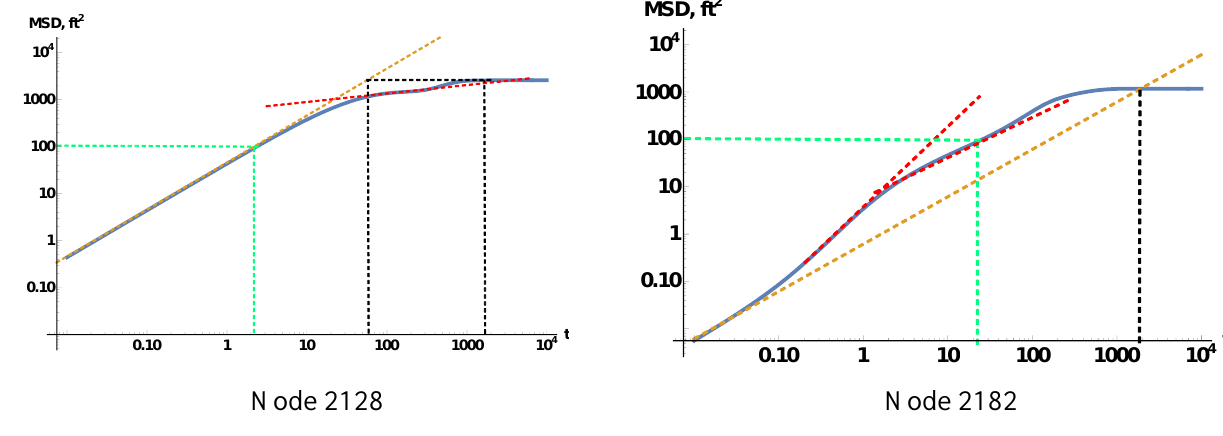
Figure 17—log-log plots of MSD vs. time for 10 sampled nodes in Case